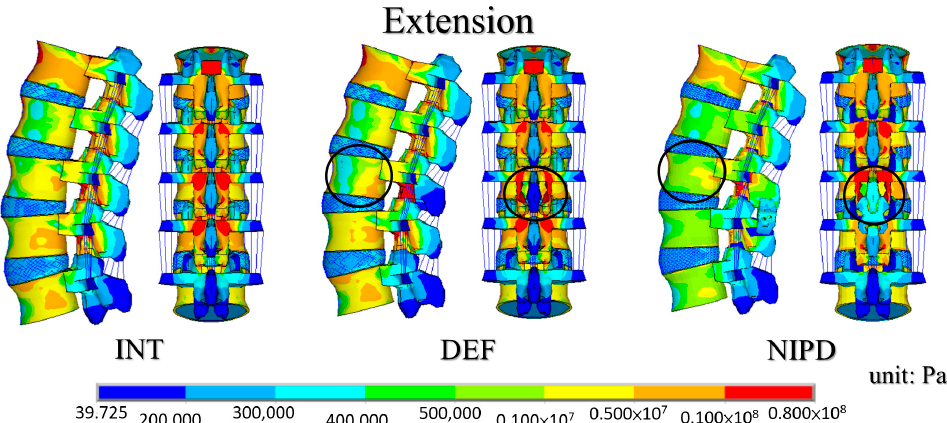
Figure 6. Stress distribution in the lumbar spine in the three FE models. Note: the circle indicates the location of the stress alteration. In the NIPD, the posterior element had higher stress (large area in red color), but the anterior vertebral body had lower stress (small area in yellow color).